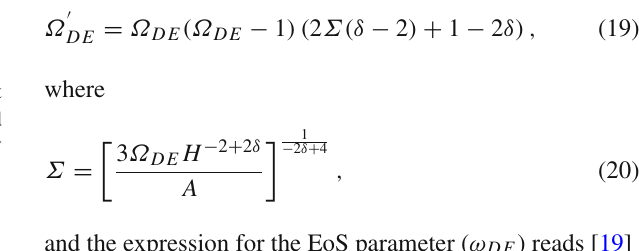
), and da attains a minima da